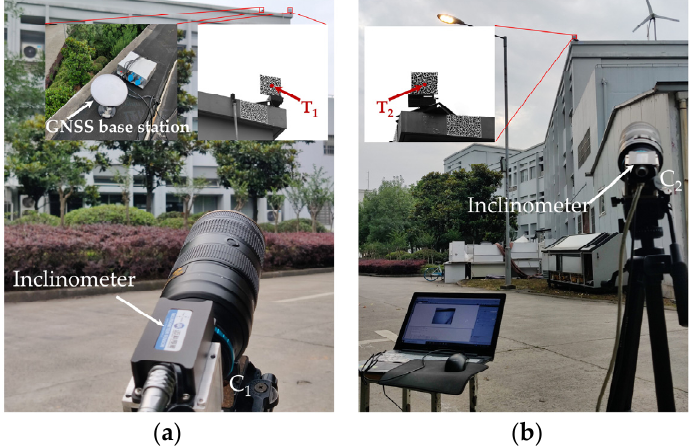
Figure 10. Experiment setups for ( a ) camera C 1 ; ( b ) camera C 2 .